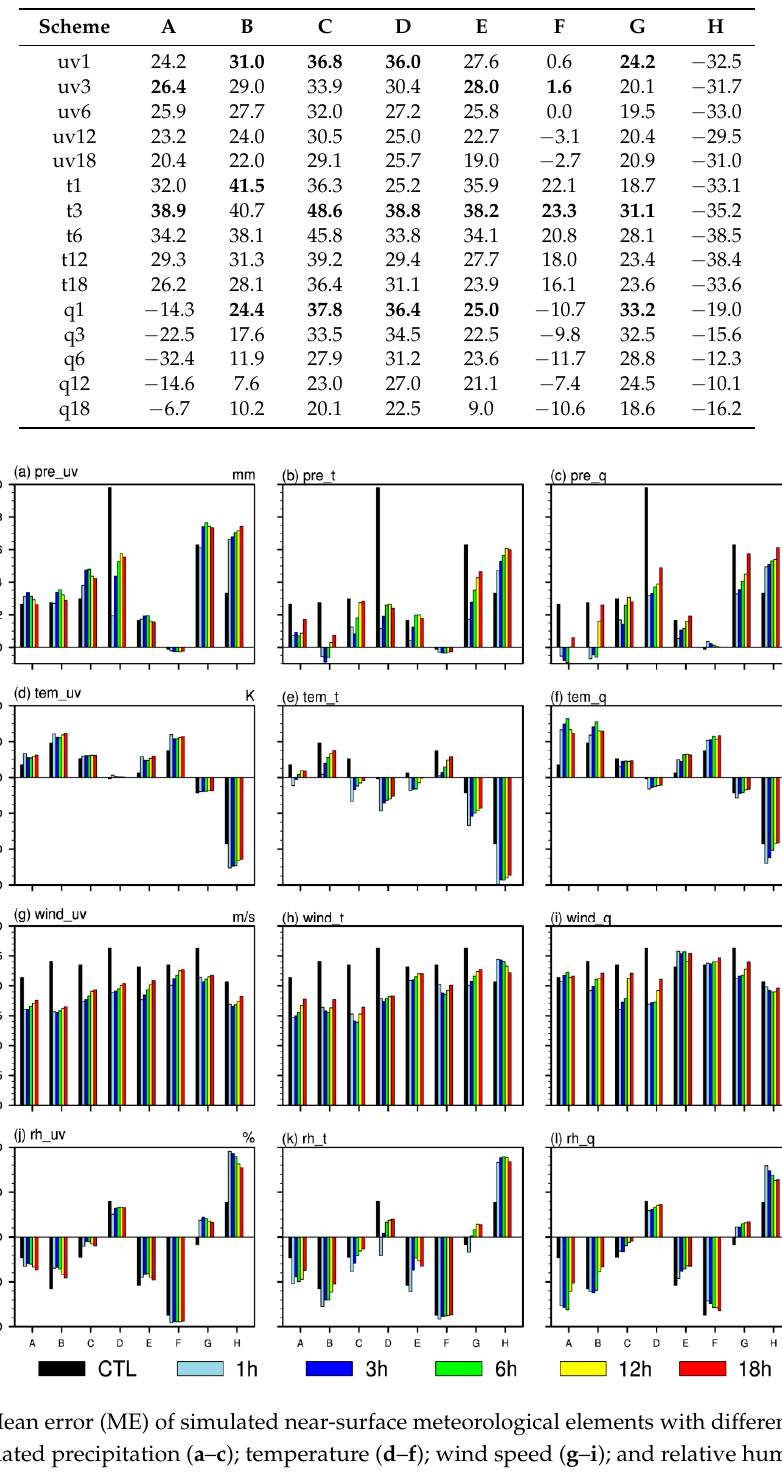
Table 2. The mean improvement rate (RATE) (%) of simulated meteorological elements near the surface with different nudging time (Bold type indicates the optimum nudging time in this region).